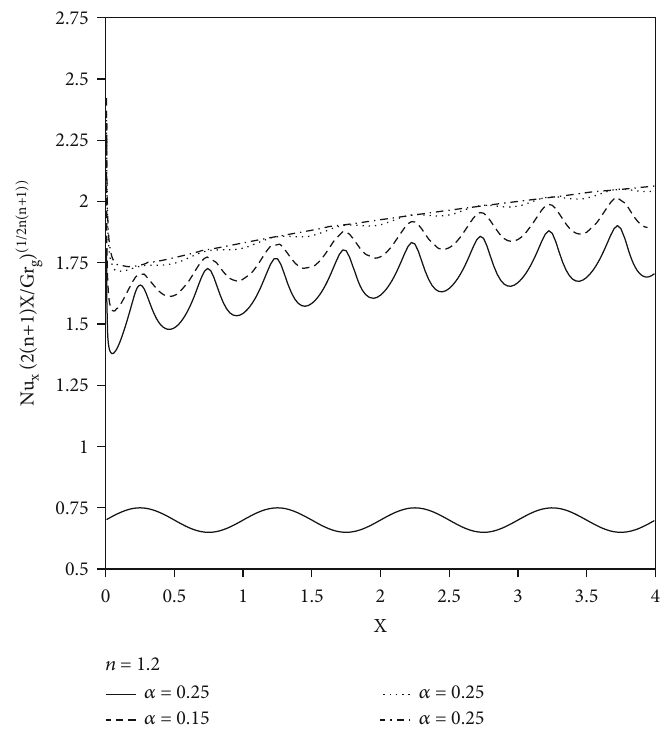
Figure 10: The axial distribution of the local Nusselt number for Pr